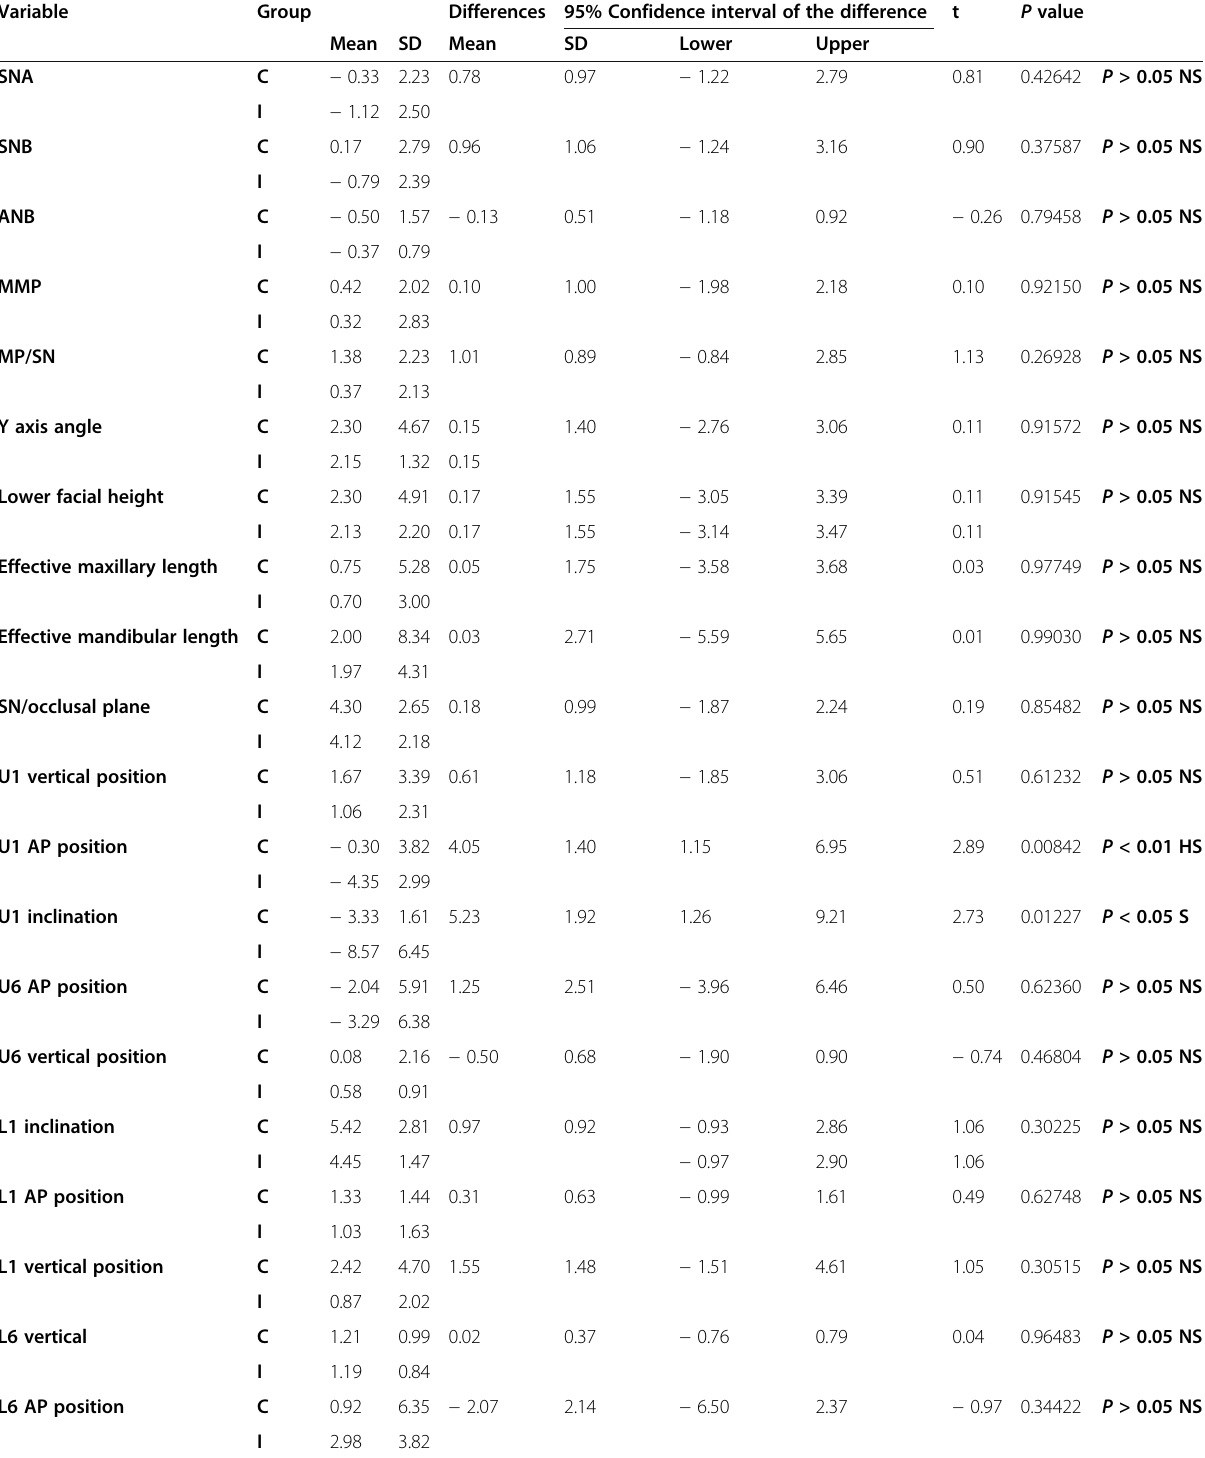
Table 4 Independent samples T test for comparing the differences in the dental and skeletal changes after class II elastics phase for between the 2 groups